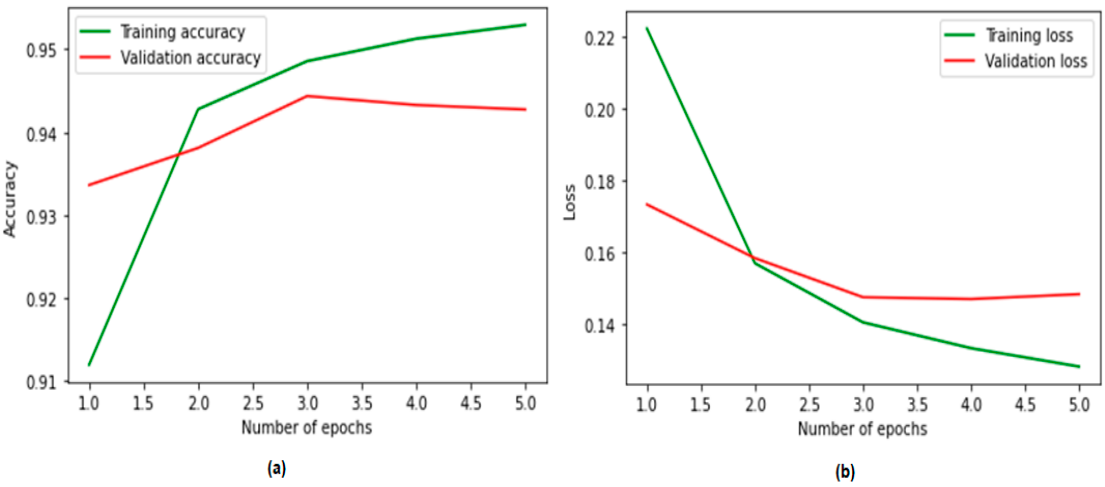
Figure 6. Training and validation ( a ) accuracy and ( b ) loss using textual features.